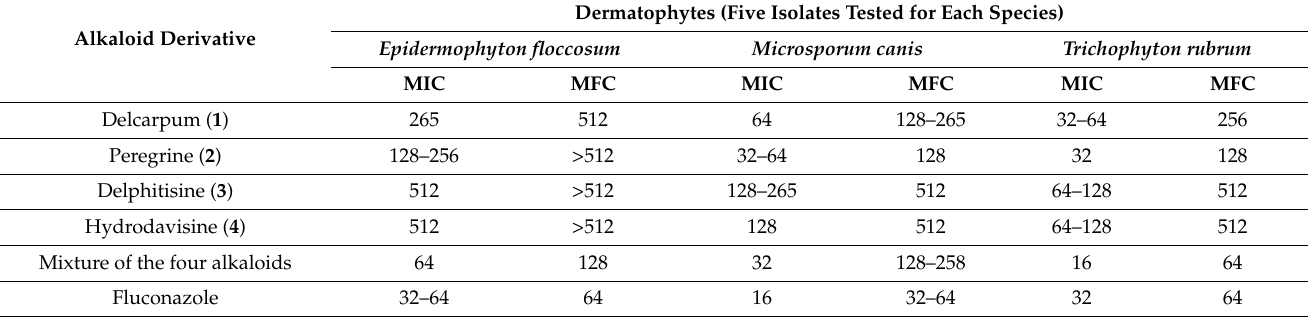
Table 2. Range of minimum inhibitory (MIC) and minimum fungicidal concentrations (MFC) of synthesized alkaloid isolated from Delphinium peregrinum L. var. eriocarpum Boiss against different dermatophyte fungal isolates measured as µ g/mL. Dermatophytes (Five Isolates Tested for Each Species) Alkaloid Derivative Epidermophyton